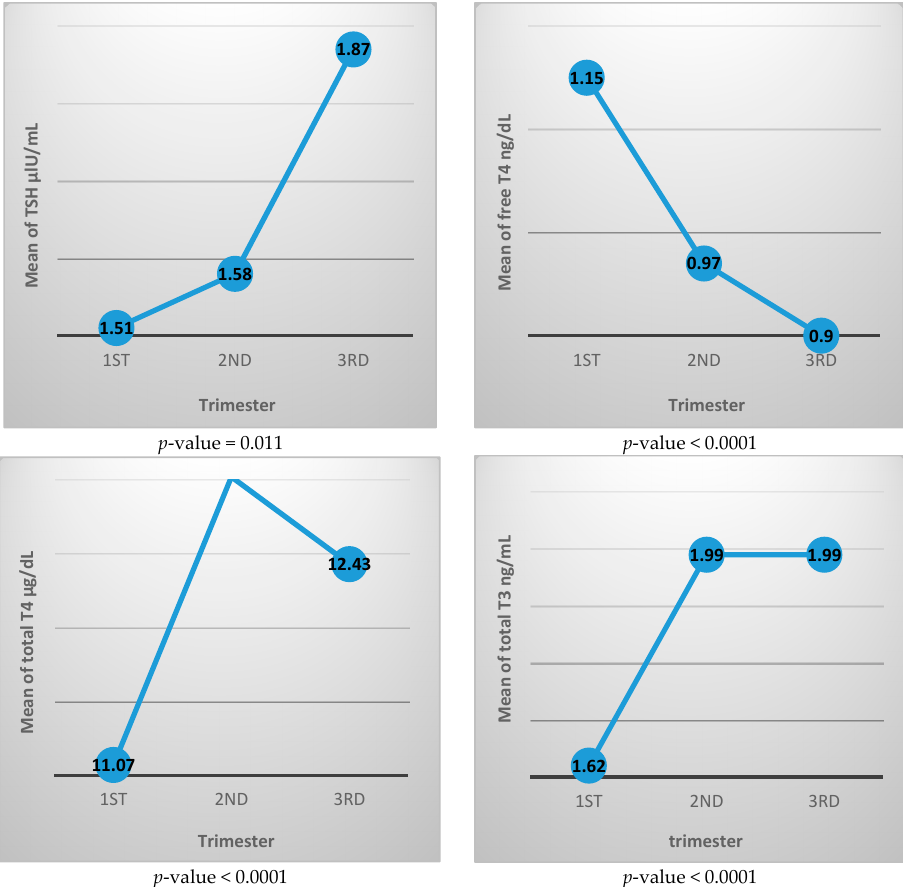
Figure 2 . Mean value of thyroid function tests for each trimester. Figure 2. Mean value of thyroid function tests for each